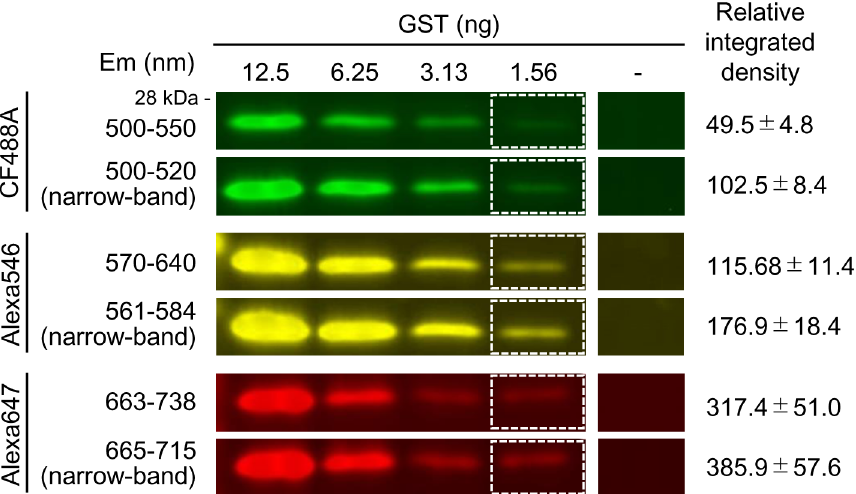
Fig 2. Reduction in noise signals by narrowing emission wavelength region. Effects of using narrow-band filters on detection sensitivity. Joined images of dilution series of GST and background area are shown. GST was visualized using anti-GST antibody and fluorescent dyes conjugated to secondary antibody (CF488A, Alexa 546, and Alexa 647). Emission wavelength (Em) of filters and relative integrated density of 1.56 ng GST using general filters (upper lane) and narrow-band filters (lower lane) are shown (mean ± standard error of three independent experiments). Exposure time was 1/3 seconds in the normal filter and 1/7.5 seconds in the narrow-band filter in detecting GFP and Alexa 546, and was 1–1.5 seconds in the normal filter and 1.5 seconds in the narrow-band filter in detecting Alexa